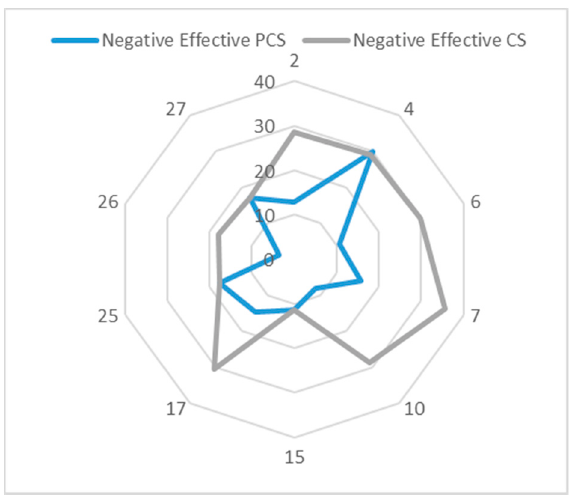
Figure 8. Comparison of negative effect under PCS and CS.